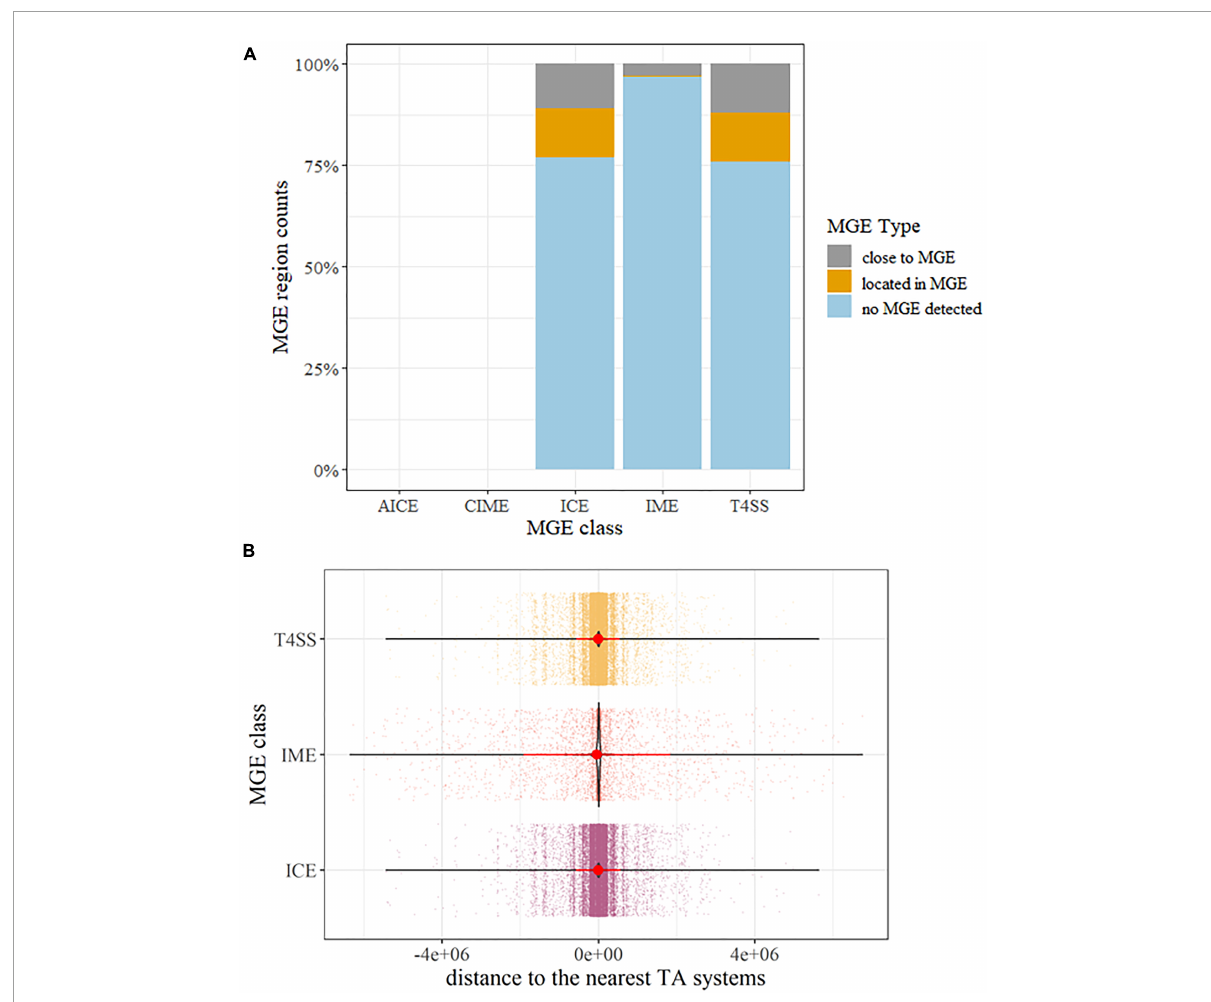
FIGURE5 Overview of the identified mobile genetic elements (MGEs) associated with TA systems. (A) percentage barplot of MGEs detected on the same sequences carrying TA systems. Abbreviation: ICE, integrative and conjugative element; IMEs, integrative and mobilizable elements; AICE, actinomycete ICE, CIME, cis -mobilizable elements; T4SS, type IV secretion system type ICE. (B) Distance distribution of the MGE to the TA systems. Dots represent distances between TA and the nearest MGE on the same contig sequences or replicons. The violin plot highlights the condense distribution of MGE close to TA systems. Red dots are means and the line shows the range of standard deviation. If a TA was detected inside MGE regions, the distances were calculated as